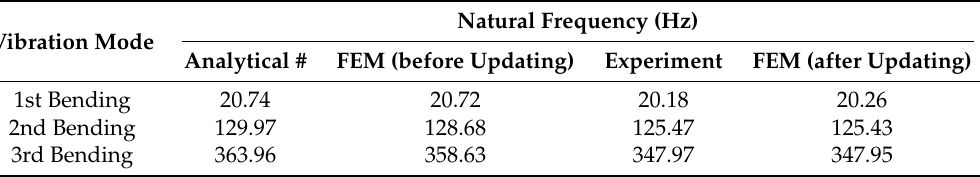
Table 3. Natural frequencies of the cantilever beam.